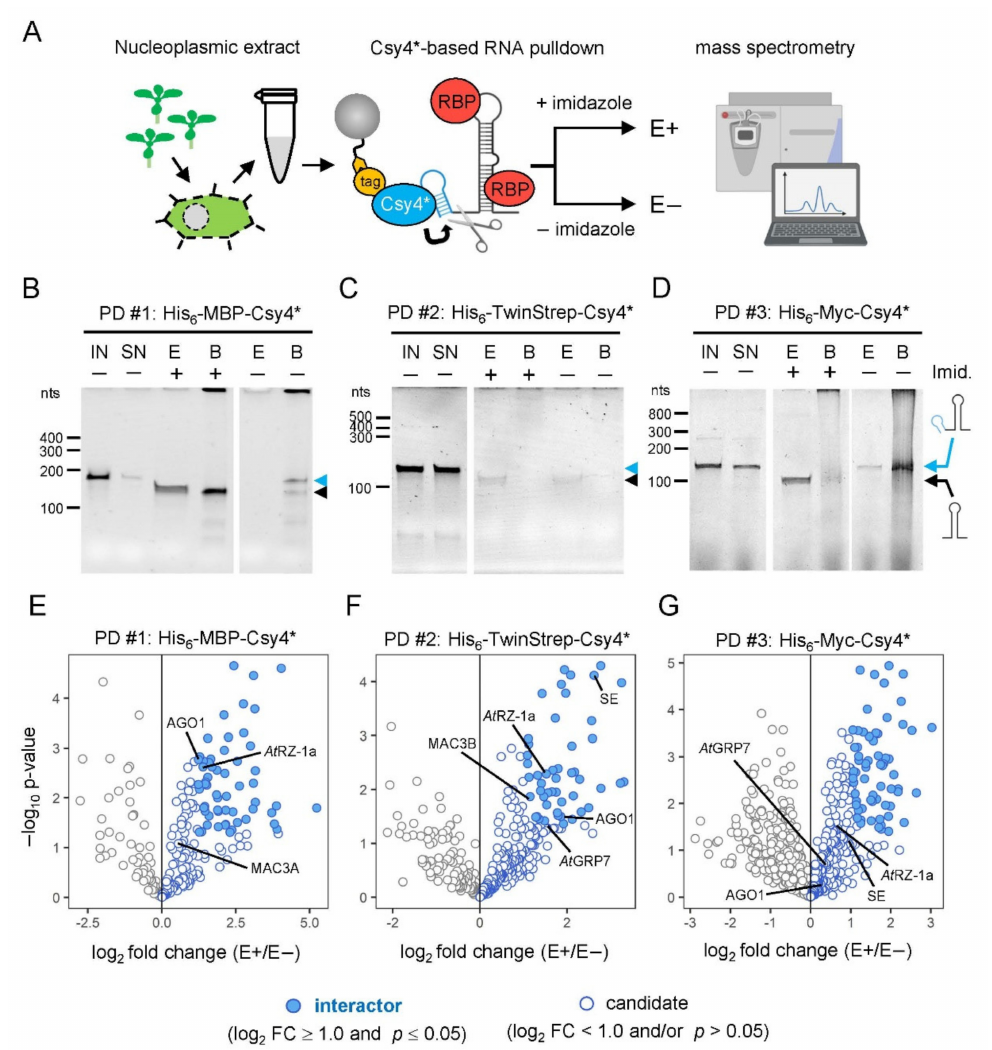
Figure 1. Identification of specific pri-miR398b stem-loop interacting proteins. ( A ) Schematic rep- resentation of the Csy4*-based RNA pulldown strategy to identify pri-miRNA stem-loop interacting proteins. The scissors indicate cleavage activity upon imidazole supply. RBP, RNA-binding protein. ( B – D ) In vitro cleavage activity of His 6 -MBP-Csy4* ( B ), His 6 -TwinStrep-Csy4* ( C ) and His 6 -Myc- Csy4* ( D ). Cleavage products were separated on denaturing urea-PAGE gels and visualized with SYBR TM Gold staining. IN, input RNA. SN, supernatant after RNA coupling. E+, eluted fraction with imidazole. E − , control fraction without imidazole. B+, remaining beads after elution with imidazole. B − , remaining beads without imidazole elution. Imid., imidazole. ( E – G ) Volcano plots showing the proteins co-purified with the pri-miR398b stem-loop using either His 6 -MBP-Csy4* ( E ), His 6 -TwinStrep-Csy4* ( F ) or His 6 -Myc-Csy4* ( G ). Proteins with a p -value ≤ 0.05 and a log 2 fold change (FC) ≥ 1.0 are defined as interactors. Proteins with a p -value > 0.05 and/or a log 2 FC < 1.0 are defined as candidates. AGO1: ARGONAUTE 1. MAC3A and 3B: MOS4-ASSOCIATED COMPLEX 3A and 3B. At GRP7: Arabidopsis thaliana GLYCINE-RICH PROTEIN 7. SE: SERRATE. For the recombinant expression of His 6 -MBP-Csy4* in E. coli , we used the origi- nal Gateway-based pHM-GWA_Csy4H29AS50C expression vector (Figure S1A) [21,33]. The expression of the 64.9 kDa His 6 -MBP-Csy4* protein is efficiently induced by the addition of IPTG and the fusion protein is purified via Ni-NTA affinity resin with